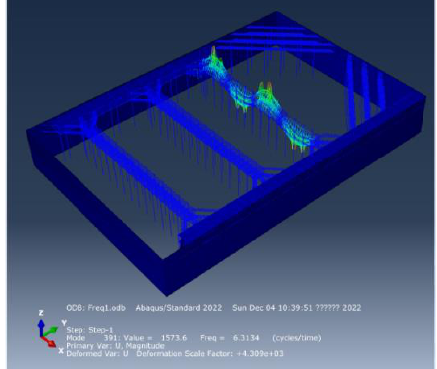
Figure 6. Vertical second-order vibration mode (6.31 Hz).